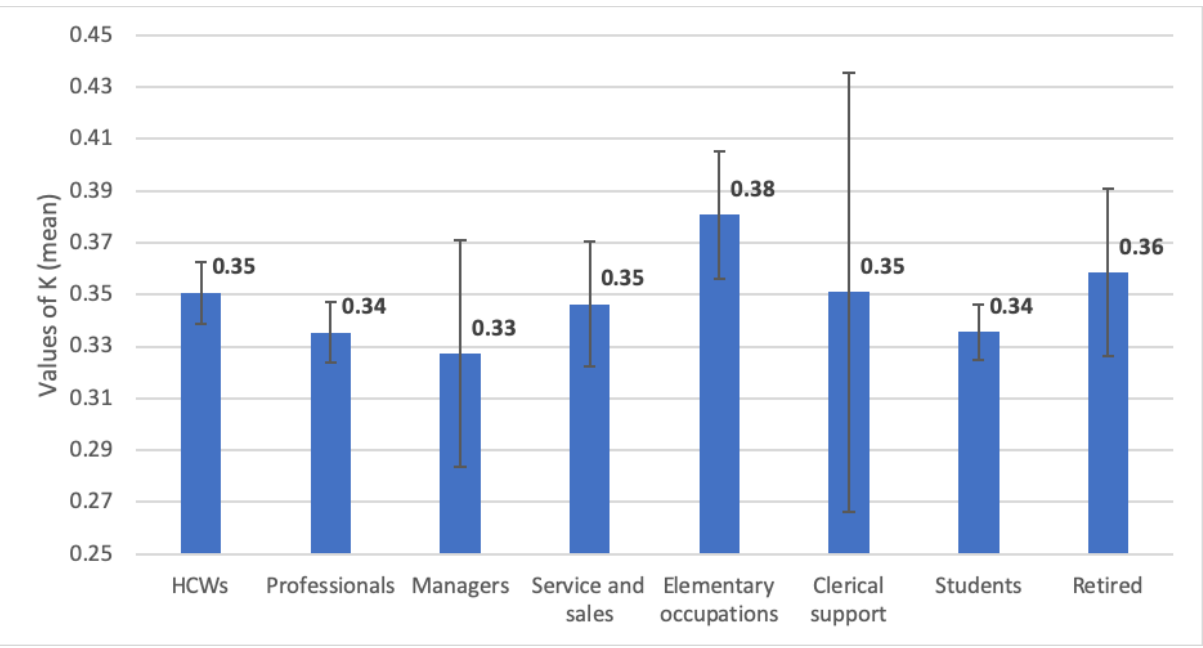
Figure 2. Graphical representation of K mean values (± 95% CI) across occupation subgroups.